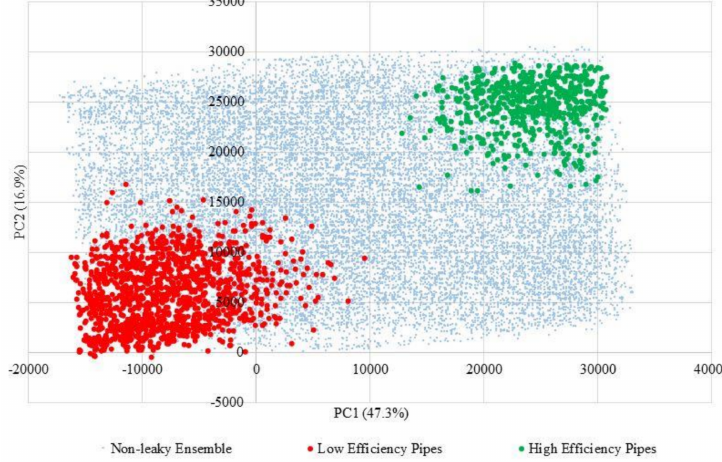
Figure 6. Bi-plot of high/low efficiency clusters in the non-leaky ensemble.